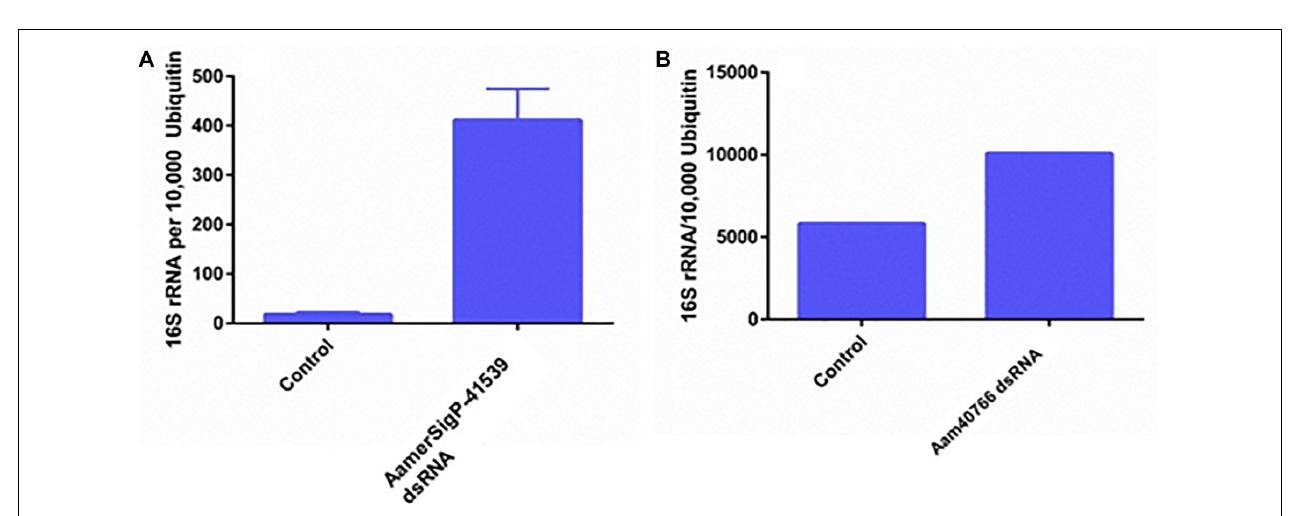
FIGURE 4 | AFM-QNM images of the cement cone obtained from an Aam-41539 silenced tick. (A,a) , and (B,b) are the height and modulus images of the section 1, and 2 of the cement cones, respectively. An average modulus of 2.5, and 6.2 GPa was obtained for the section 1, and 2, respectively.